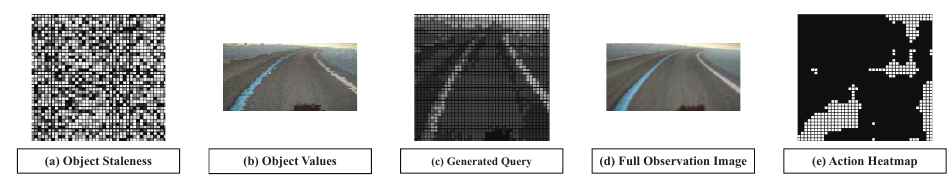
Figure 18. Internal data examples in the case study system: the examples ( a – c ) containing the system state are captured in the framework, example ( d ) is captured internally in the simulator, and example ( e ) is in the object-image mapper. Note that the full observation ( d ) is only available inside the simulator, and is not used by the framework or the driving agent; it is presented here only for comparison purposes.